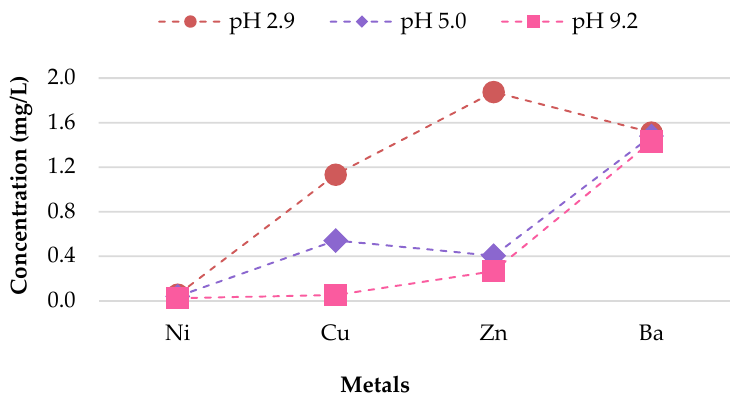
Figure 16. Variable relationship observed between metal concentrations leached from 1% CB bricks and pH value.